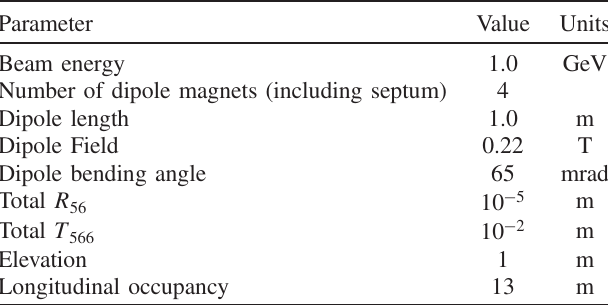
TABLE III. Parameters of the vertical dogleg.